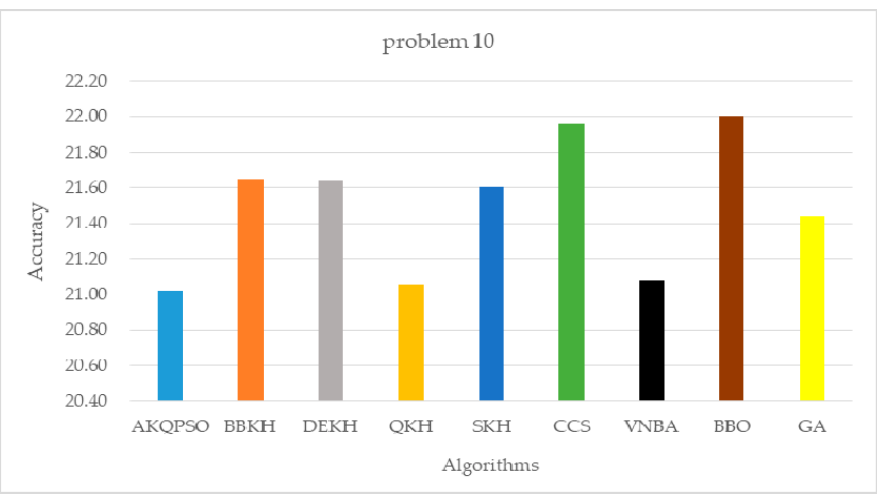
Figure 11. Accuracy of AKQPSO and other algorithms on problem 9: happy cat function.